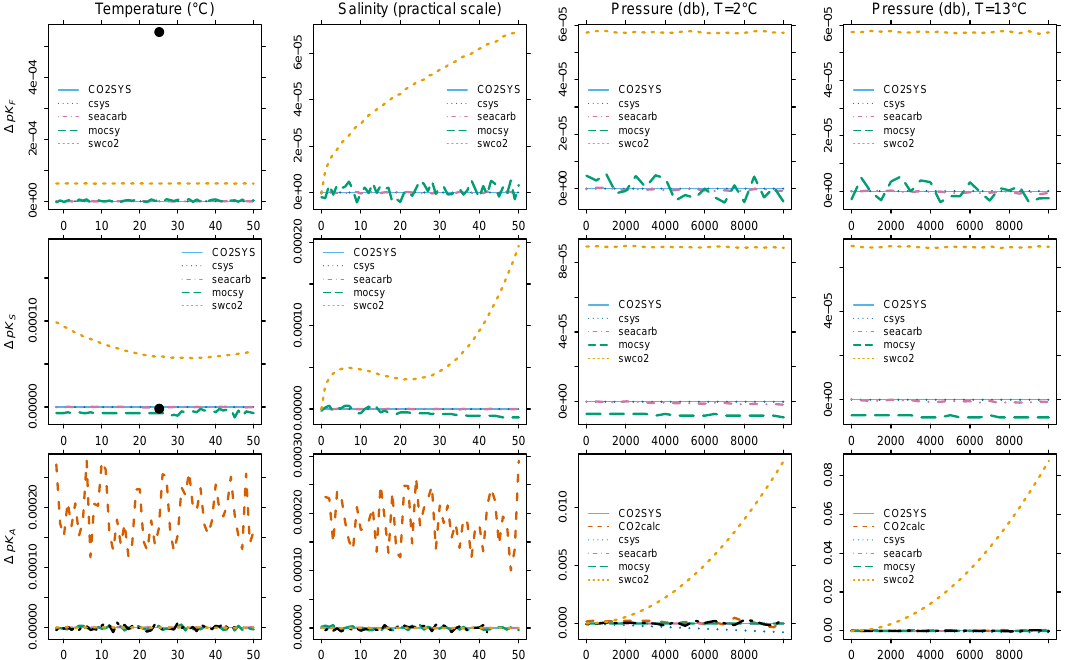
Figure 18. The p K F (top), p K S (middle), and p K A (bottom) computed from each package minus corresponding values from CO2SYS- MATLAB. The formulation for K F is from Dickson and Riley (1979) as recommended by Dickson and Goyet (1994), with all packages on the free scale. The formulation for K S is from Dickson (1990a) and on the free scale, while that for K A is from Mucci (1983) with no scale, as recommended for best practices. The filled black circles indicate check values (Table